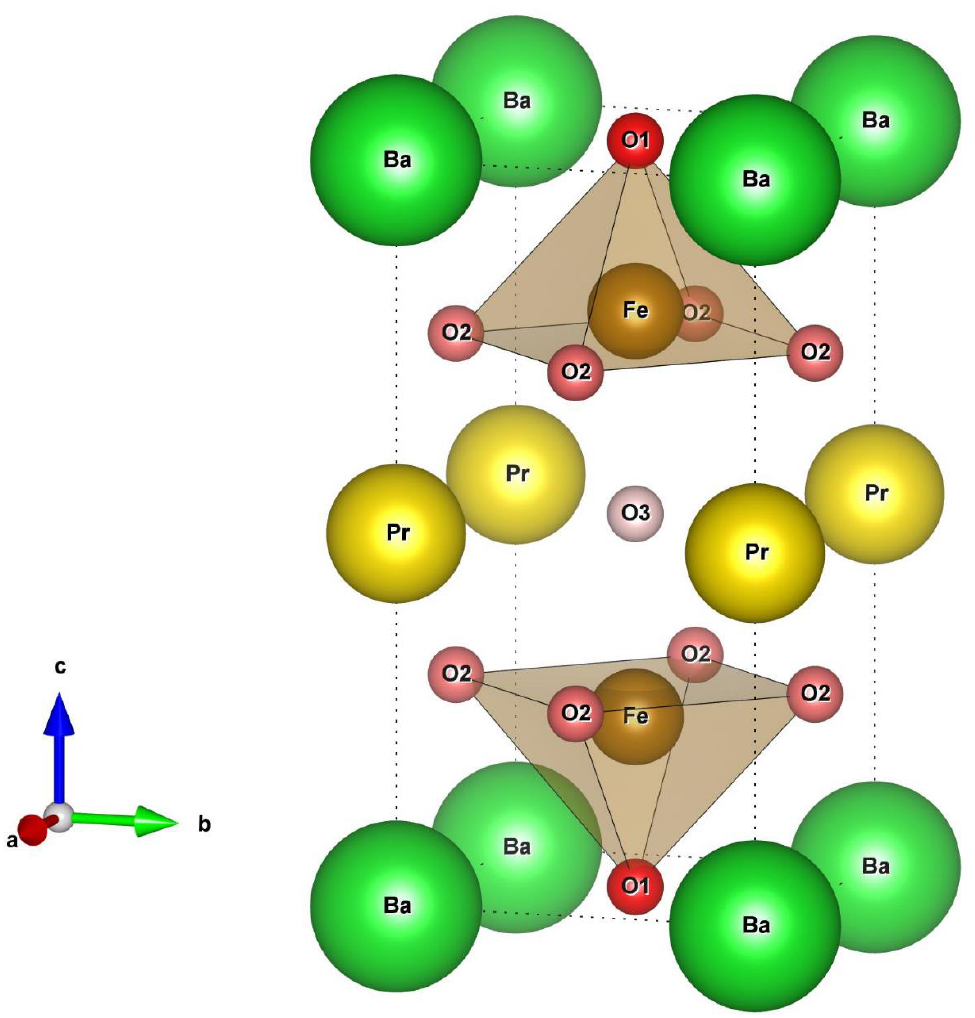
Figure 1. Unit cell of double perovskite PrBaFe 2 O 6− δ . O3 position has the lowest occupancy.